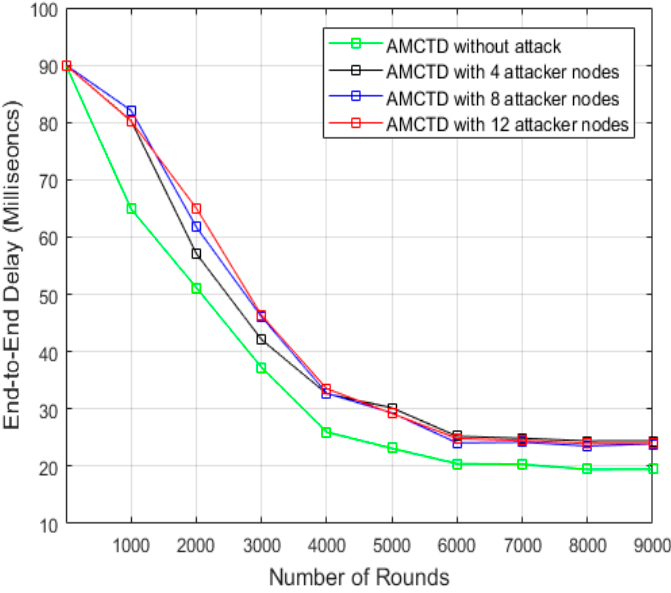
Figure 12. AMCTD: End-to-End Delay without attack and 4, 8 and 12 Attacker Nodes.